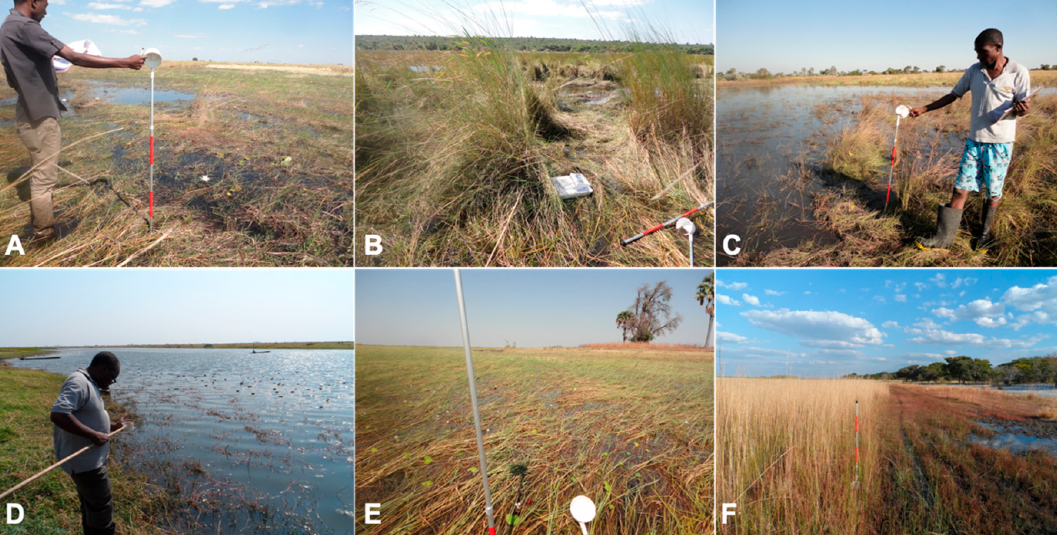
Figure 3. Example water bodies found within the study site. ( A ) mixture of matted grass, reeds, rushes and water hyacinth; ( B ) rushes, papyrus and reeds, ( C ) partially open water body; ( D ) open water; ( E ) matted grasses and water hyacinth; ( F ) edge of permanently inundated ‘dambo’ feature.